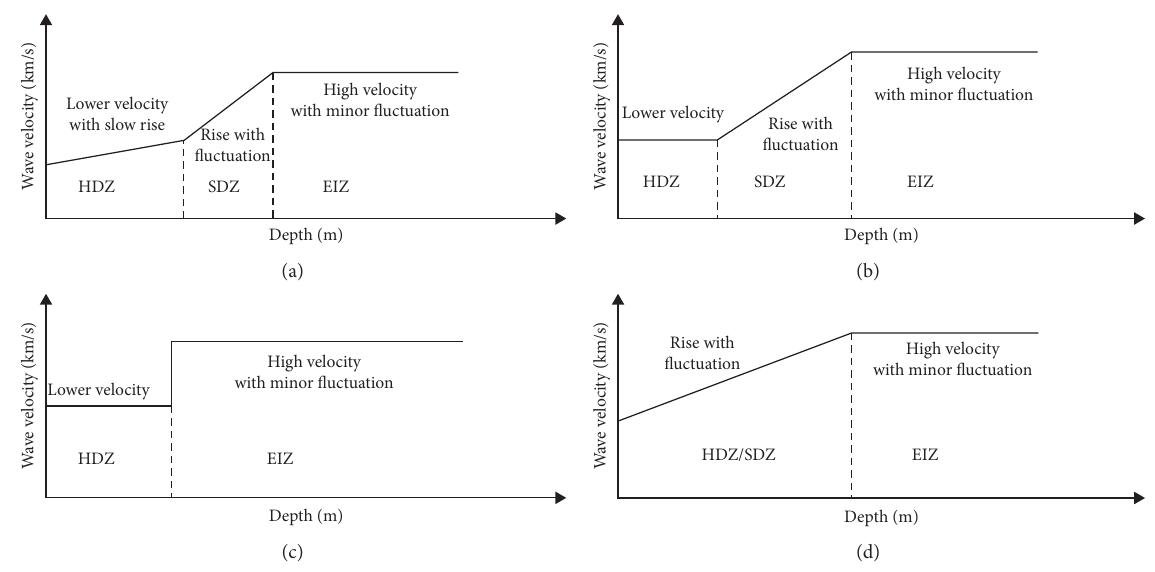
Figure 12: Four types of acoustic wave curves of the surrounding rock mass in the underground powerhouse of the Houziyan hydropower project: (a) type I (b) type II, (c) type III, and (d) type IV.